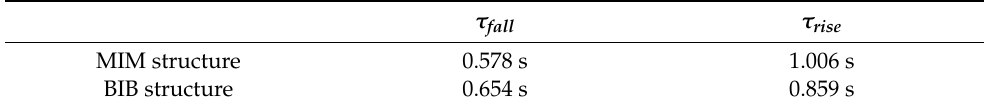
Table 1. Time constant of two samples.